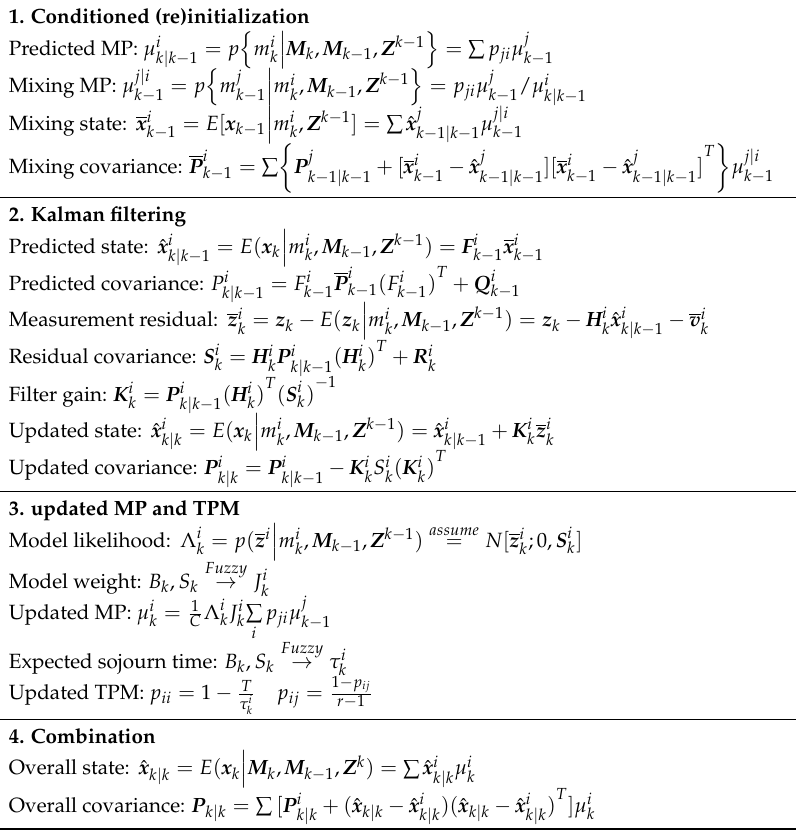
(expected sojourn time of the i -th model). k